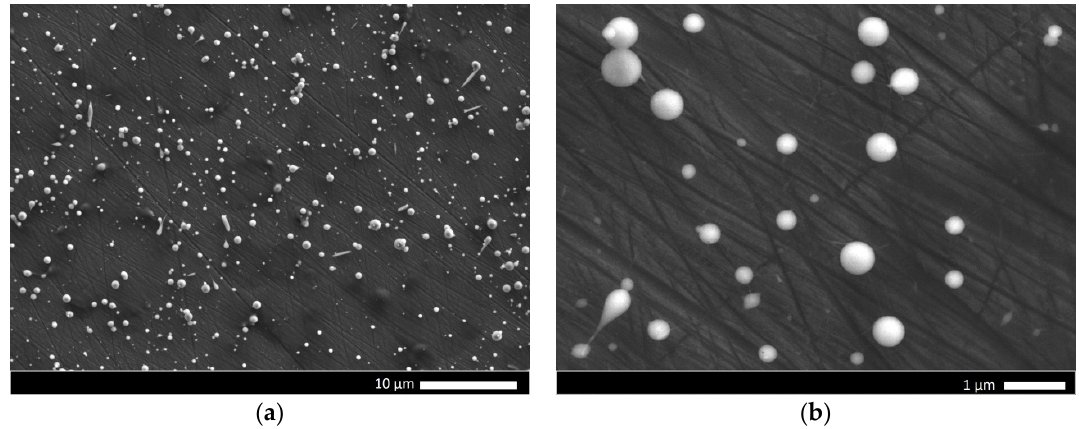
Figure 8. SEM photomicrographs of nanoparticles electrosprayed from the hyaluronic acid solutions with concentration 5.0 mg/mL under 30 kV: ( a ) magnification 4000×; ( b ) magnification 25,000×.